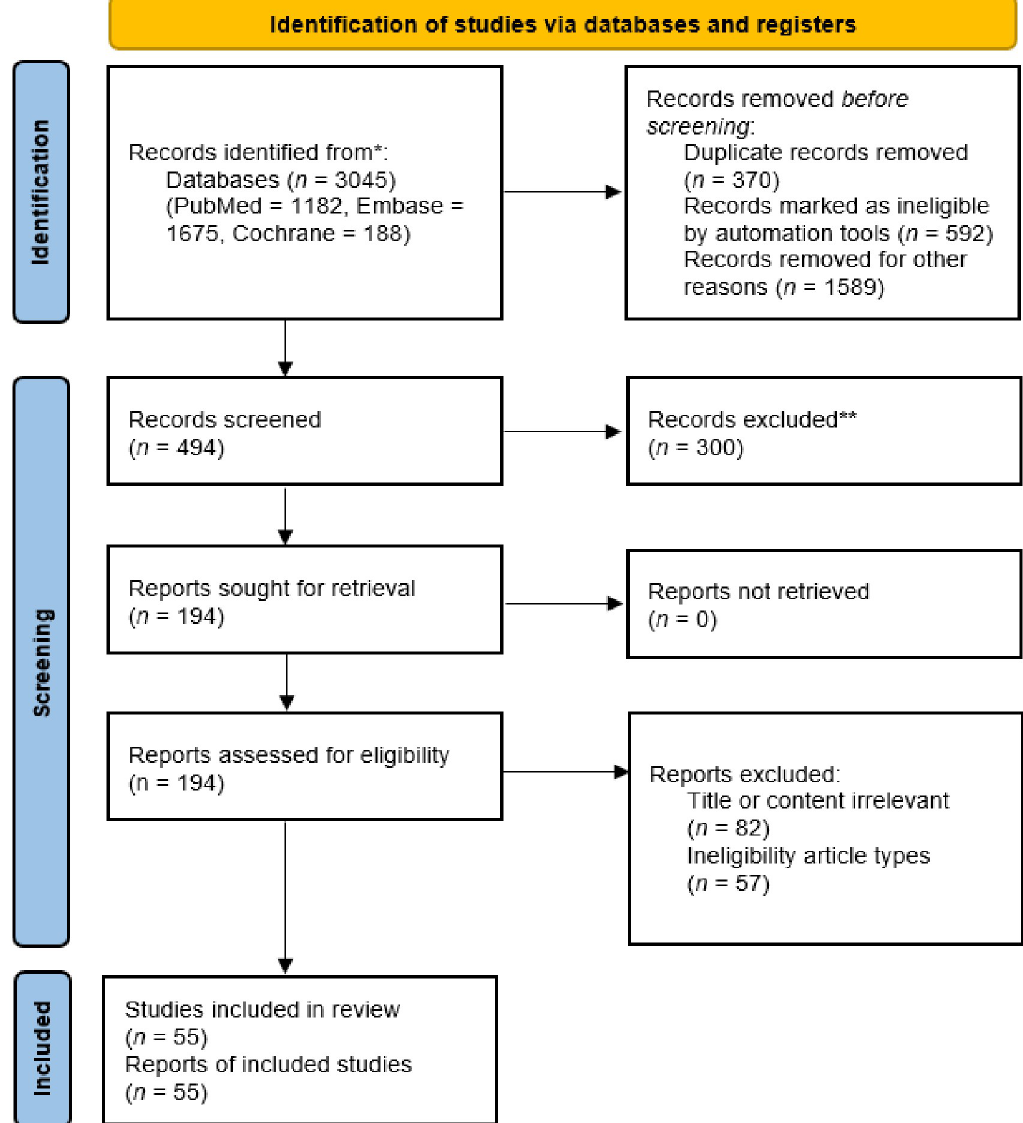
Fig 1. Flow diagram of the studies identified. � Consider, if feasible to do so, reporting the number of records identified from each database or register searched (rather than the total number across all databases/registers). �� If automation tools were used, indicate how many records were excluded by a human and how many were excluded by automation